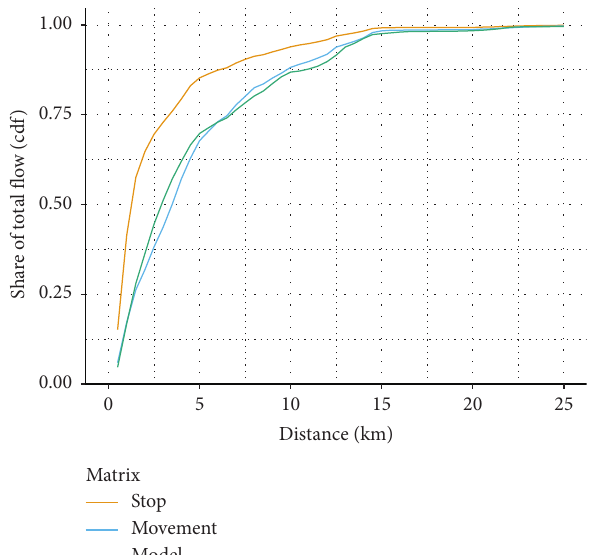
Figure 11: Distribution of the average travel demand Monday–Thursday by distance of the OD pair for the OD matrices estimated from cellular network data as well as the model (TAZ-189). The distance is based on the centroid of the